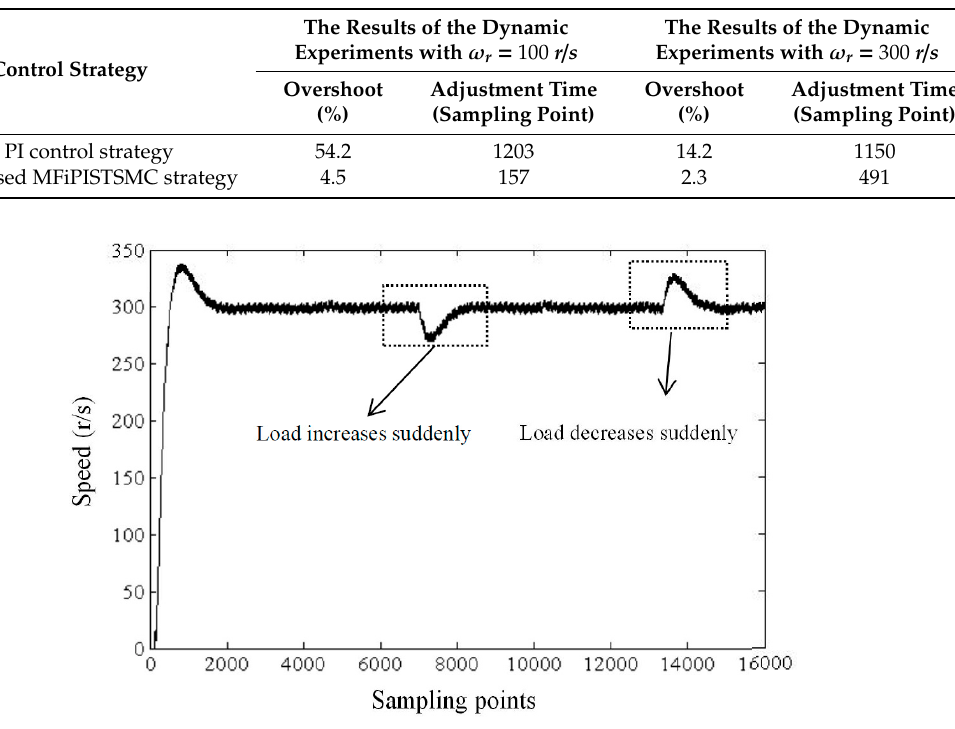
Figure 11. The experimental speed response with load changed suddenly using the Proportional- Figure11. TheexperimentalspeedresponsewithloadchangedsuddenlyusingtheProportional-Integral Integral (PI) control strategy. (PI) control strategy. Electronics 2020 , 9 , x FOR PEER REVIEW